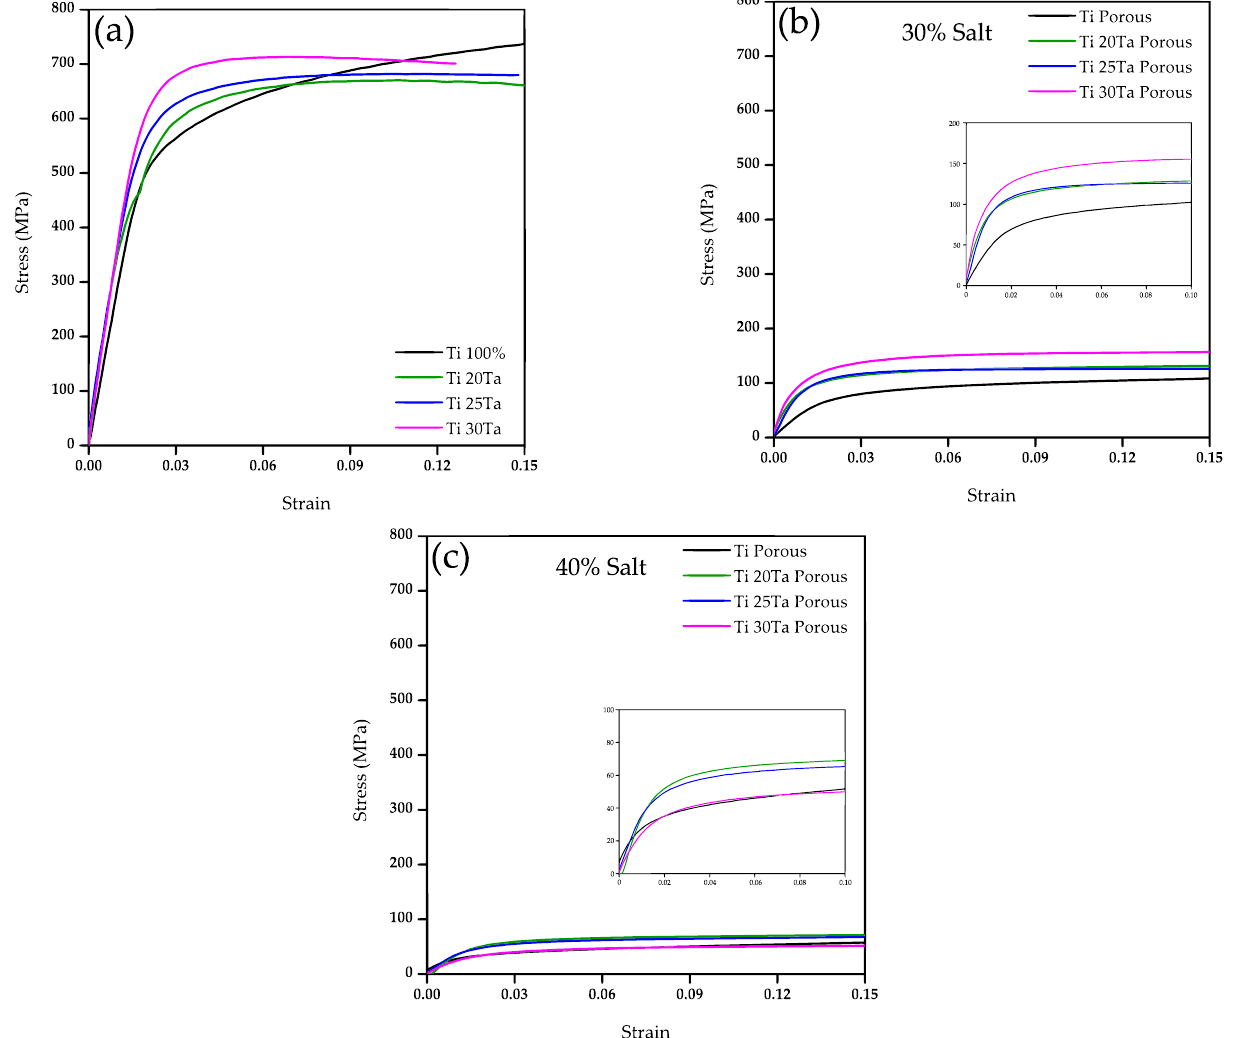
Figure 10. 3D volume renderings of porosity, with colors depicting connected pores, and stream- lines for the simulated flow of blood through the pores in the vertical and horizontal directions, with the colors depicting fluid velocity, for samples with 30 wt.% of Ta and either 30 vol.% ( a – c ) or 40 vol.%; ( d – f ) of salt particles.